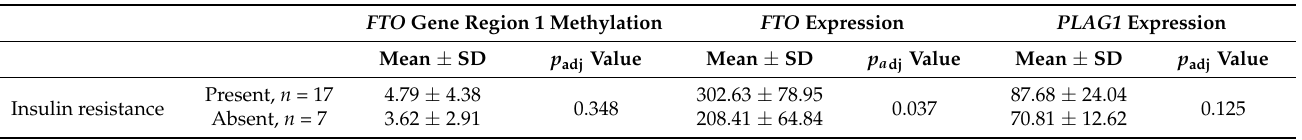
Table 5. Effect of FTO gene region 1 methylation, FTO expression, and PLAG1 expression on the presence of insulin resistance. All calculated p values were adjusted for age and sex of the children in ANCOVA.